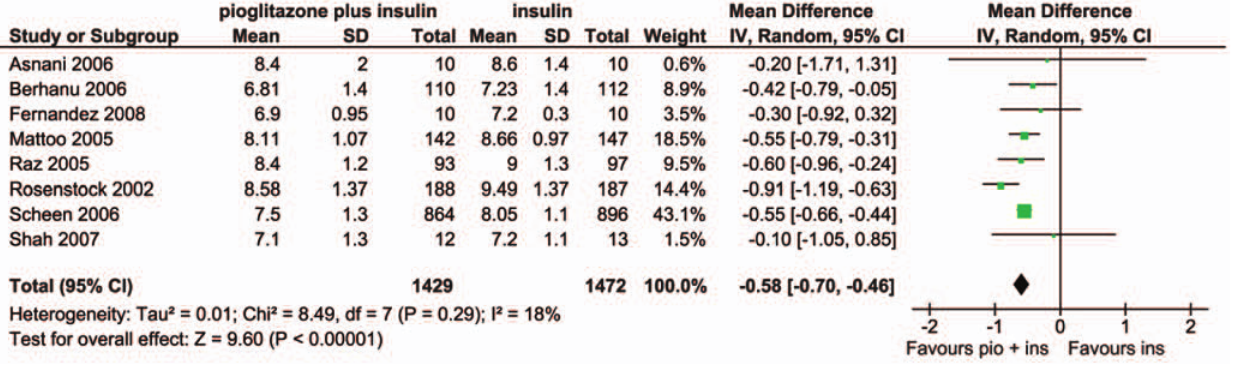
Figure 2. Forest plot of HbA1c results; SD=standard deviation, IV=inverse variance method, pio=pioglitazone, ins=insulin.